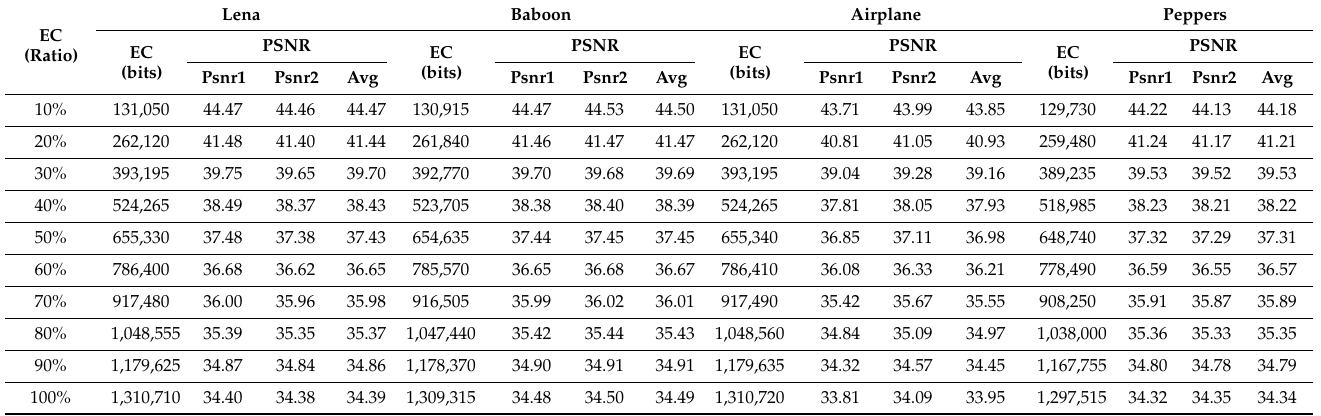
Table 6. Comparison of embedding capacity and PSNR value of different stego images for n = 4.